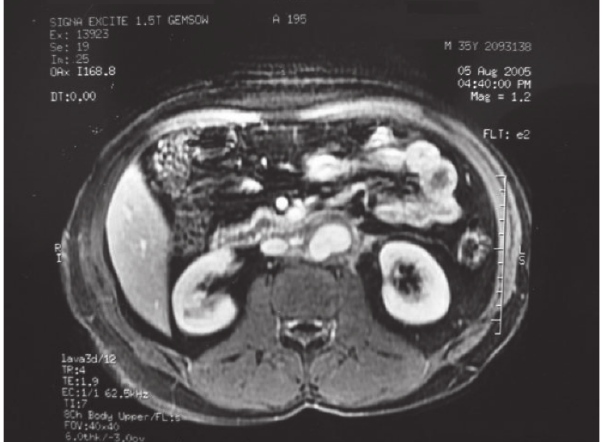
Figure 2 - Preoperative magnetic resonance angiography showing the aortic pseudoaneurysm—transversal section.